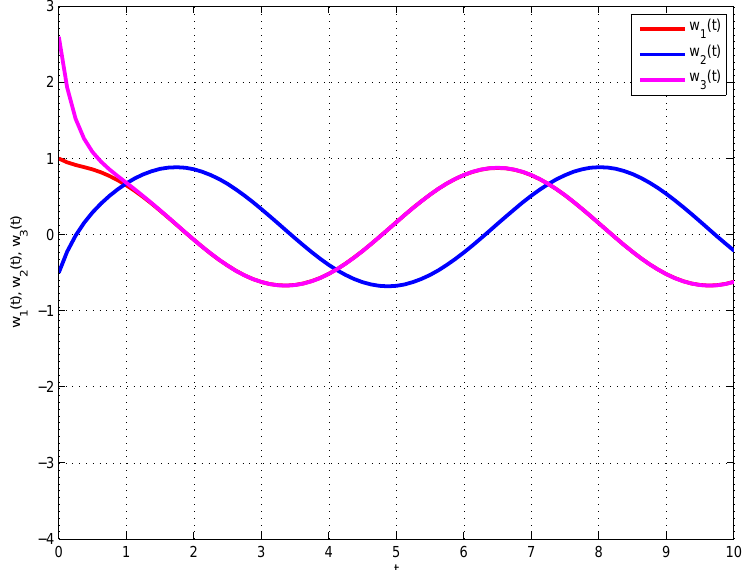
Figure 2. The time responses of the states w 1 ( t ) , w 2 ( t ) and w 3 ( t ) of system (70) for the external